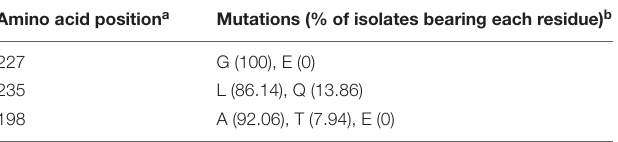
TABLE 5 | Natural mutations at three key amino acid positions in the HA of H7N9 viruses. Amino acid position a Mutations (% of isolates bearing each residue)